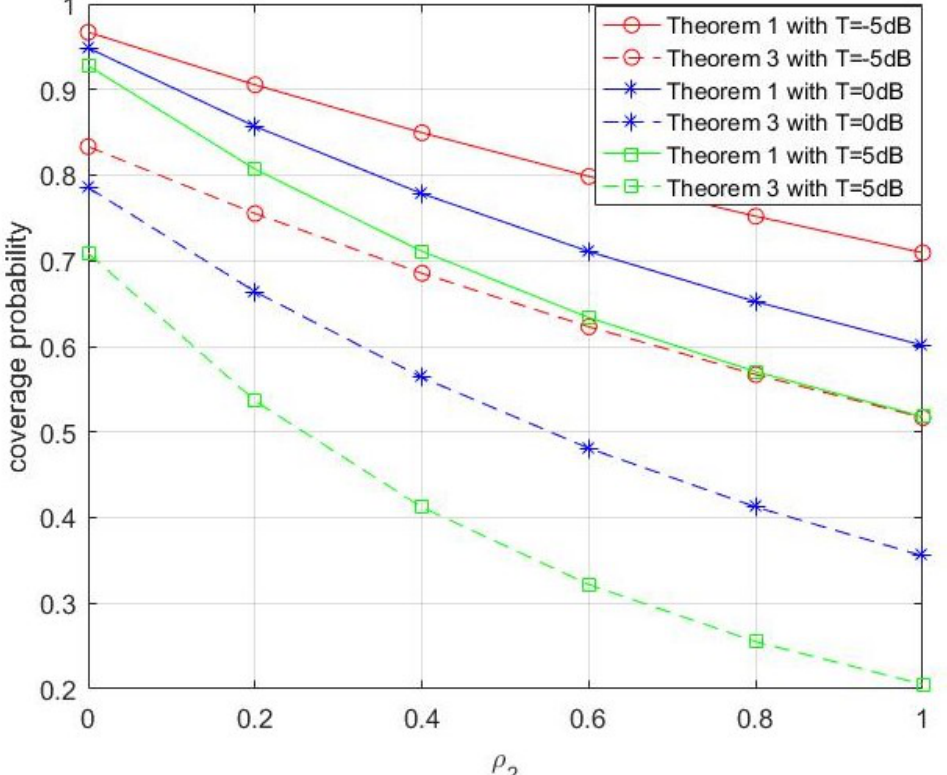
Figure 5. Conditional coverage probability in Theorems 1 and 3 v.s. ρ 2